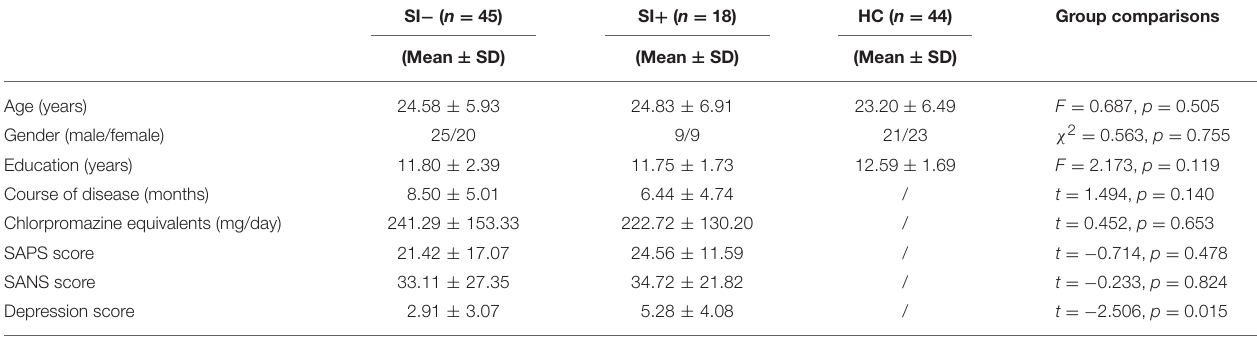
TABLE 1 | The demographic and clinical characteristics of the patients without suicidal ideation (SI–), the patients with suicidal ideation (SI + ) and healthy controls (HC).